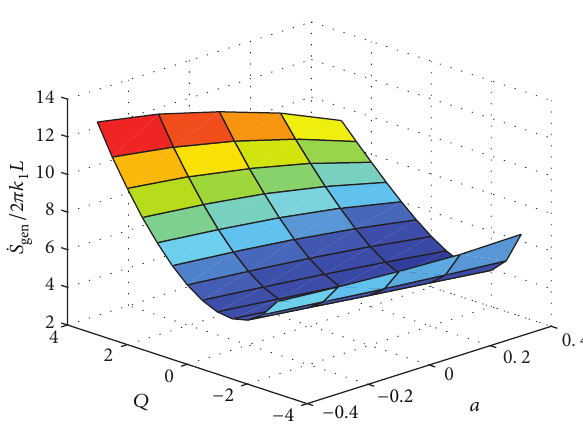
̇𝑆 with respect to “ 𝑎 ” and “ 𝑄 .” gen